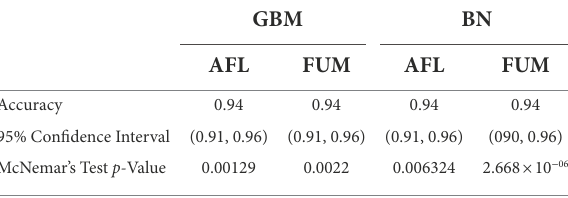
TABLE 2 Summary statistics of GBM and BN used for AFL and FUM.